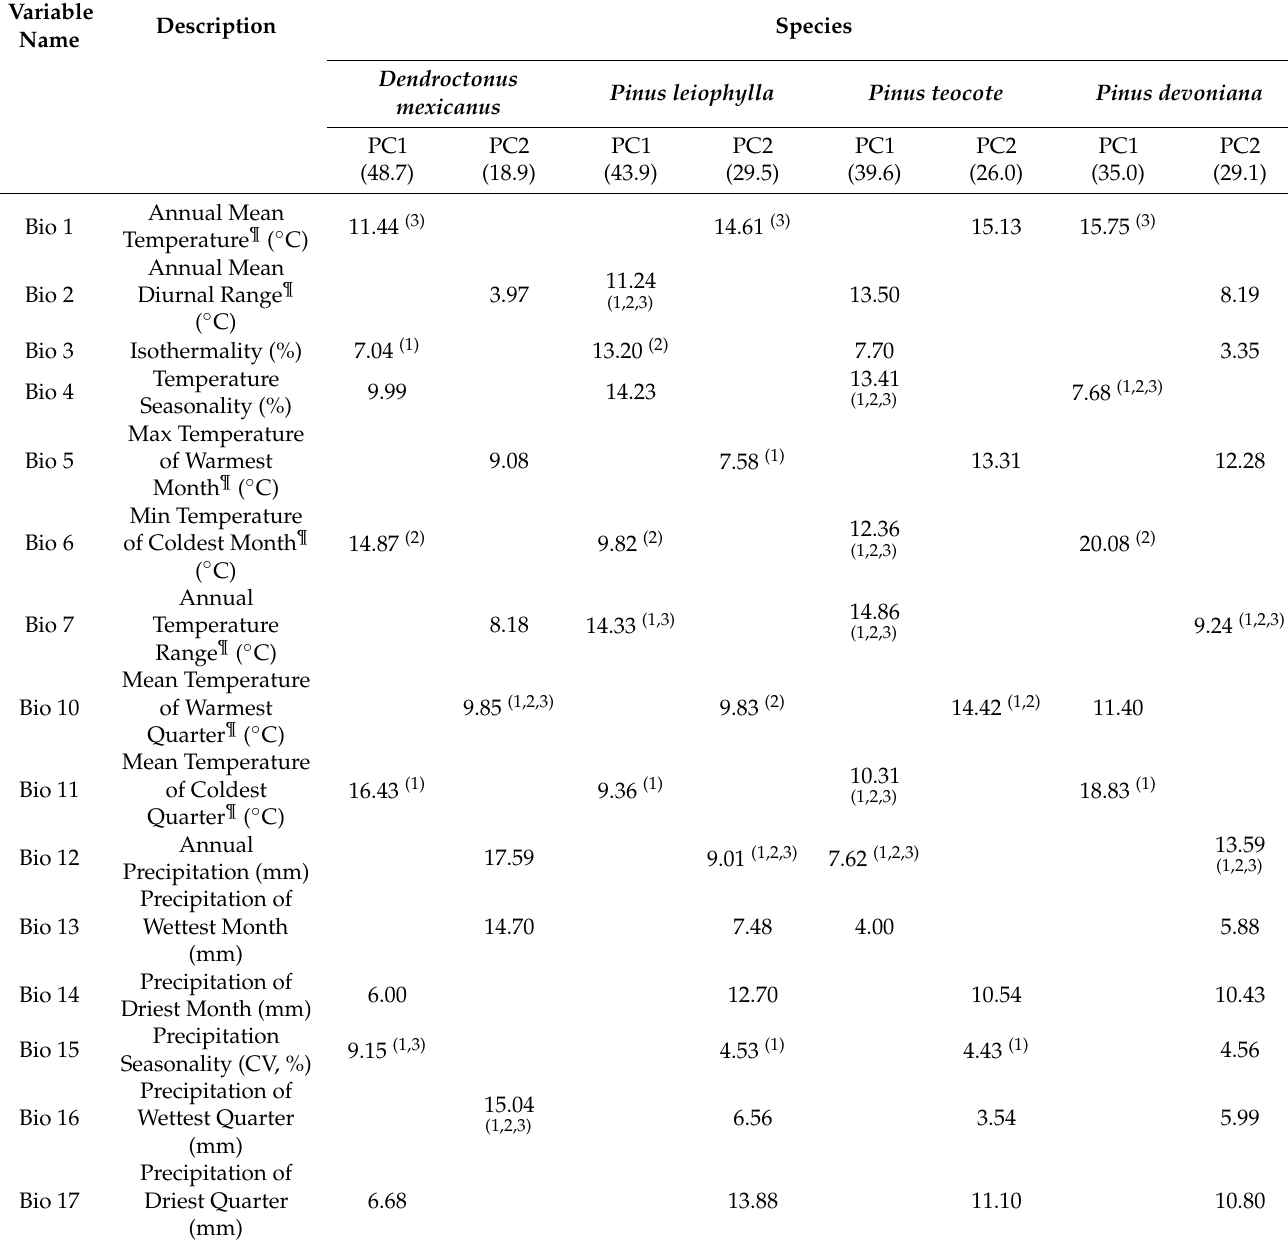
Table 1. Contribution of the bioclimatic variables determined by principal component analysis for their preselection and accommodation in different sets to conduct the species climate suitability modeling